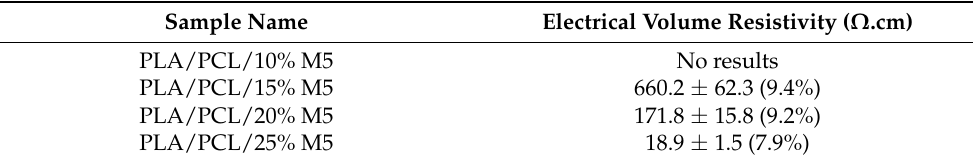
Table 6. Electrical volume resistivity of 3D-printed composites with graphene percentages starting from 10 wt.% to 25 wt.% (the raster angle of these samples is +45 ◦ / − 45 ◦ , Figure 1a).